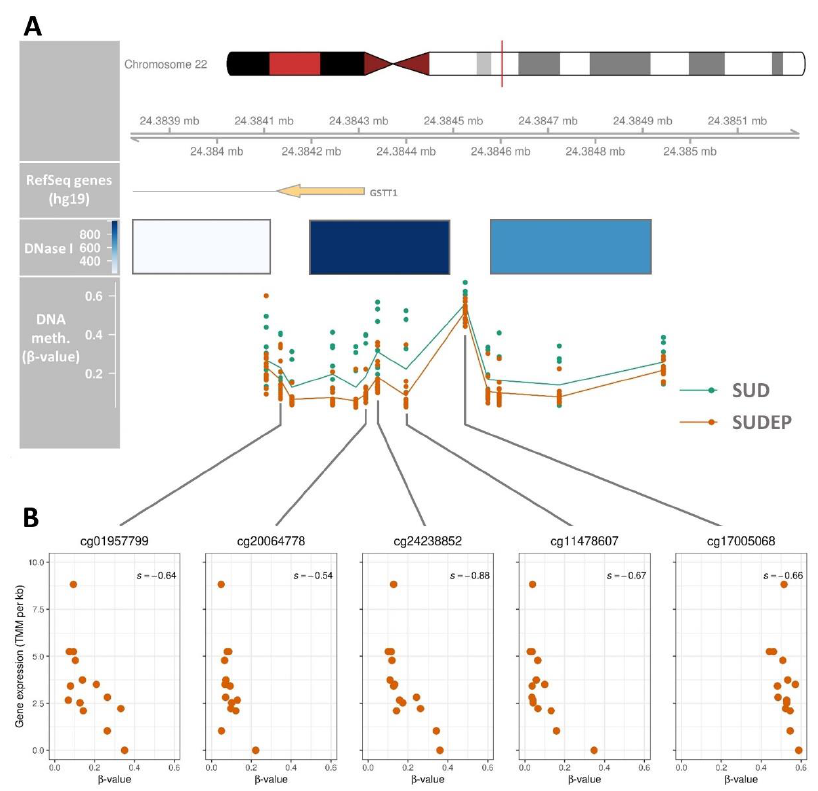
Figure 2. Regional differences of β -values from sudden unexplained death and sudden unexpected death in epilepsy cases overlapping the GSTT1 region. ( A ) DNA methylation is shown for CpG positions in the differentially methylated region (DMR) overlapping the GSTT1 region in ventricular tissues from sudden unexplained death (SUD) and sudden unexpected death in epilepsy (SUDEP). ENCODE DNase I sensitive regions are shown in blue with colour intensities corresponding to the signal strength. The lines connecting the points in the β -value track indicate the mean for each group. The DMR is located at chr22:24,384,105-24,384,944 covering 13 CpG positions. The colors in the chromosome structure correspond to chromosome staining bands and the vertical red line indicates the chromosomal location of the DMR. ( B ) The median of the three Trimmed Mean of M-values (TMM) per kb values from each individual was plotted against the β -value of each of the positions that were statistical significantly correlated ( p ≤ 0.05) with GSTT1 expression. Each CpG position is labelled with the CpG loci IDs according to the CpG nomenclature of